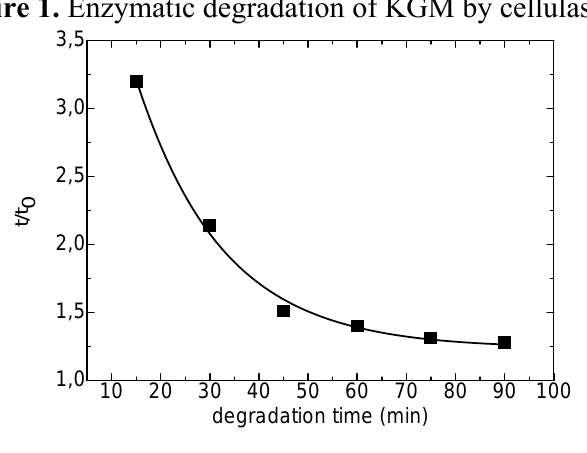
Figure 1. Enzymatic degradation of KGM by